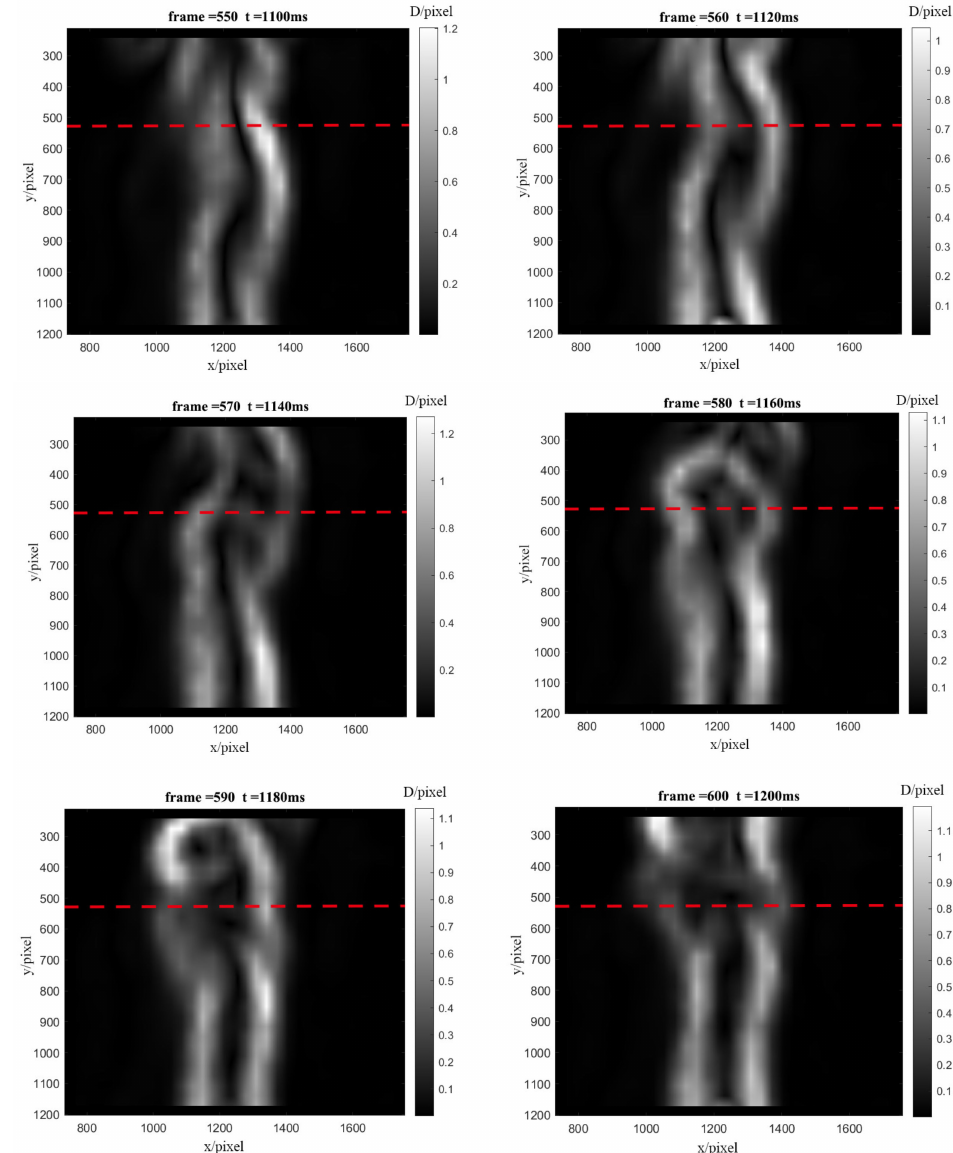
Figure 11. Schematic diagram of frame skipping baseline